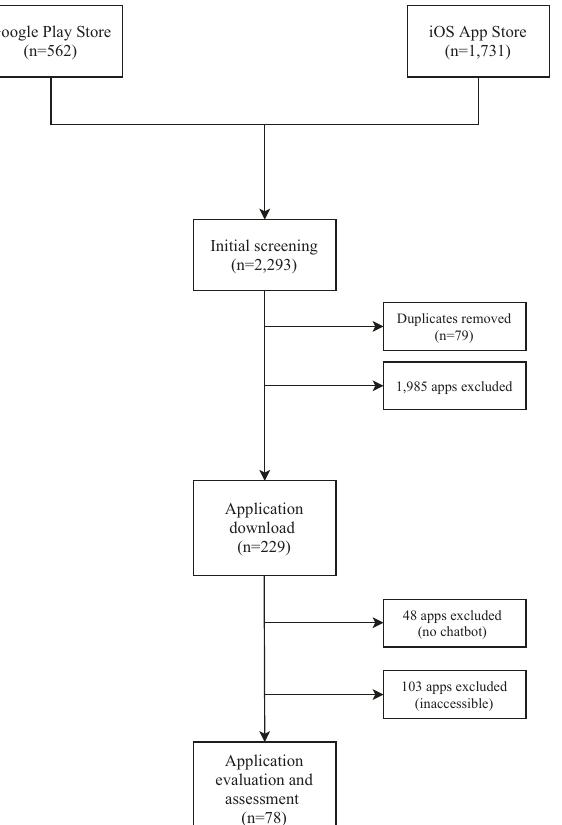
Fig. 1 Consort Diagram. This consort diagram shows the app selection process.